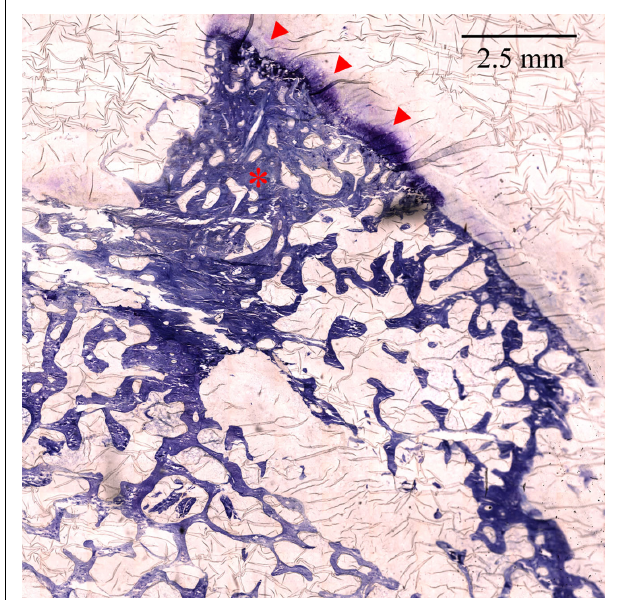
FIGURE 11 | × 100Toluidine blue stained section of the femoral head–neck junction showing an osteophyte with dense trabecular BMUs (asterisk) and a cartilage cap (arrowheads). Image prepared by Dr. Linda Skingle; sections cut by Dr. Grant Jordan. Image courtesy of the Bone Research Group, University of